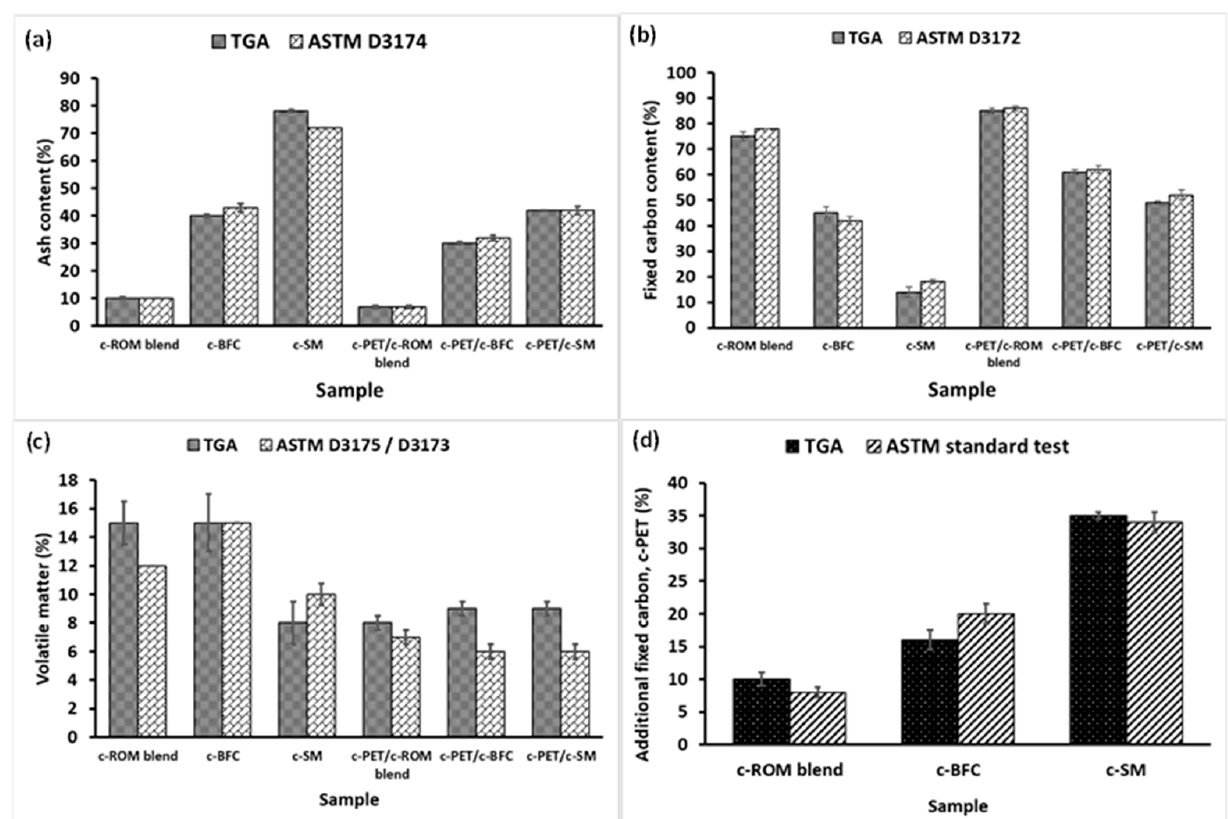
Figure 10. Graphical comparison of the fixed carbon content and additional c-PET obtained for each c-PET/d-coal composite after co-carbonization at 700 °C: ( a ) ash content as per ASTM D3174 and TGA/DSC analysis, ( b ) fixed carbon content as per ASTM D3172, ( c ) volatile matter as per ASTM D3175/D3173, and ( d ) additional PET-derived carbon, c-PET, calculated as the difference between the fixed carbon content of c-PET/d-coal and carbonized d-coal.